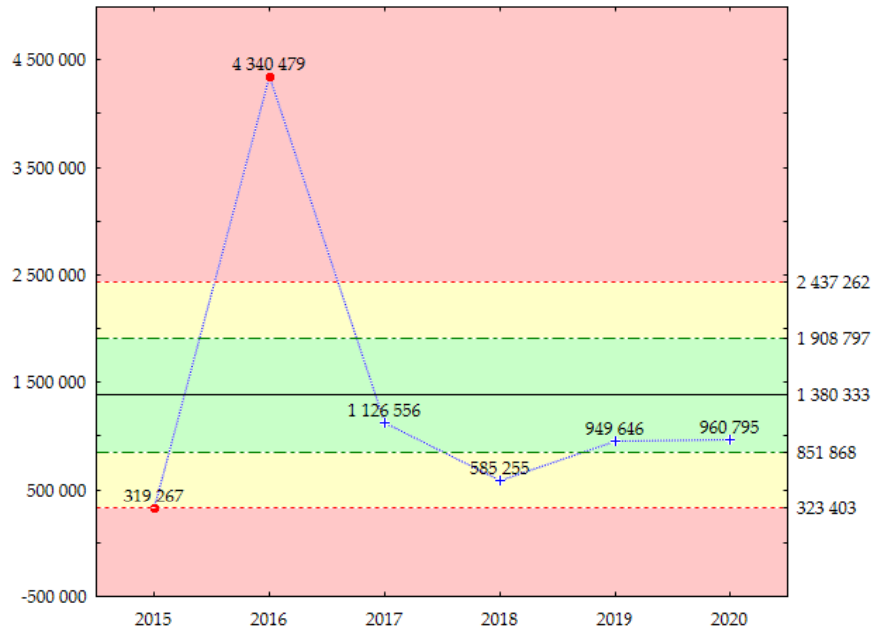
Figure 4. X-average control chart for the energy intensity of inland waterway transport on all sections of the Odra River. Note: The central line for the energy intensity is 1,380,332.85 kJ/ton, and the sigma for the energy intensity is equal to 528,464.61 kJ/ton. Source: own elaboration.